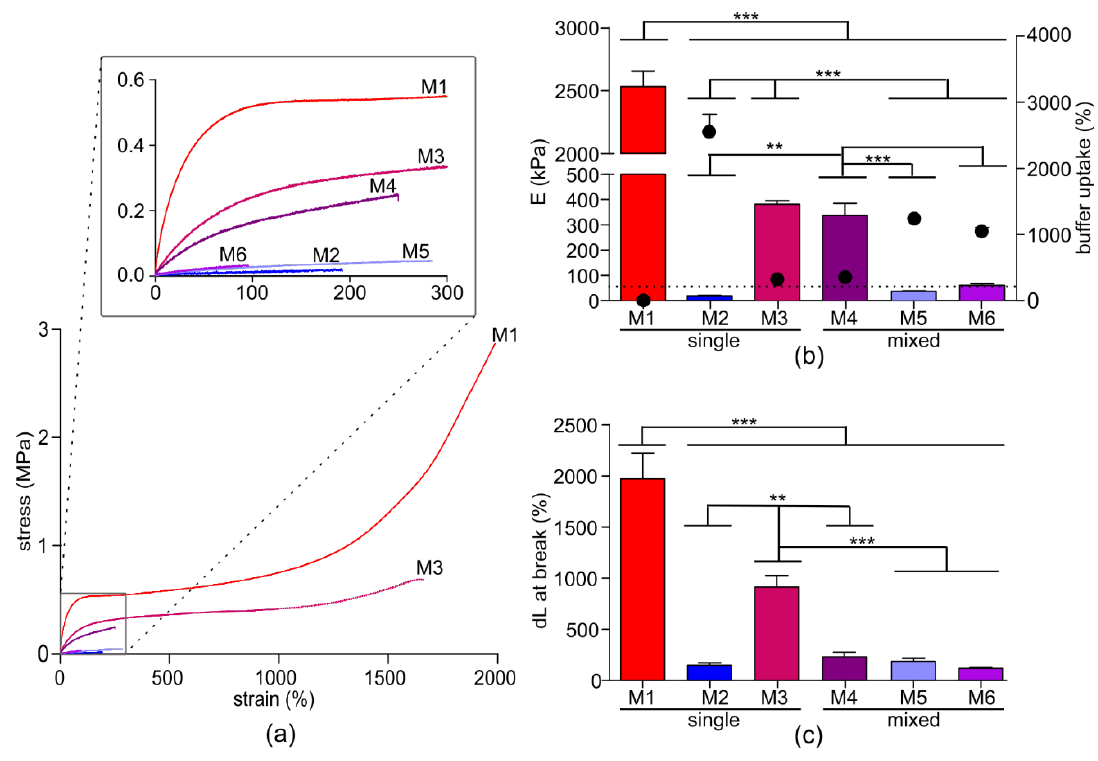
Figure 2. Mechanical properties and buffer uptake of the membranes. ( a ) Stress-strain curves of the membranes, with an inset of the first 300% strain. ( b ) Ashby plot of the Young’s modulus (bars, left Y-axis) vs. the buffer uptake (dots, right Y-axis) of the membranes. The dotted line indicates the maximum physiological stiffness of 50 kPa ( c ) Elongation at break of the membranes. * p < 0.05, ** p < 0.01, *** p < 0.001.